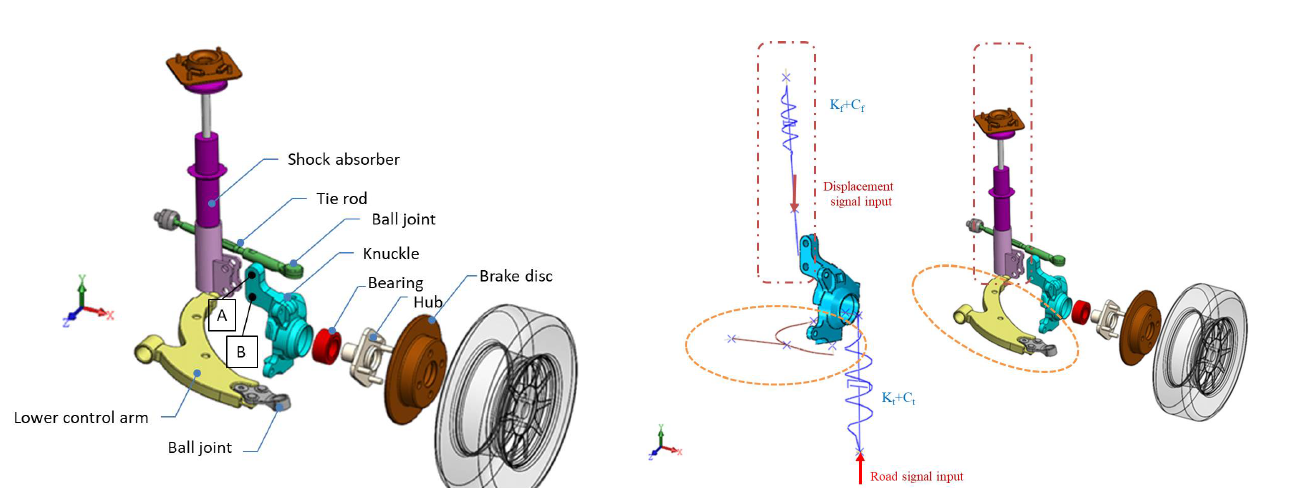
Figure 9. Boundary condition setting for impact load simulation.